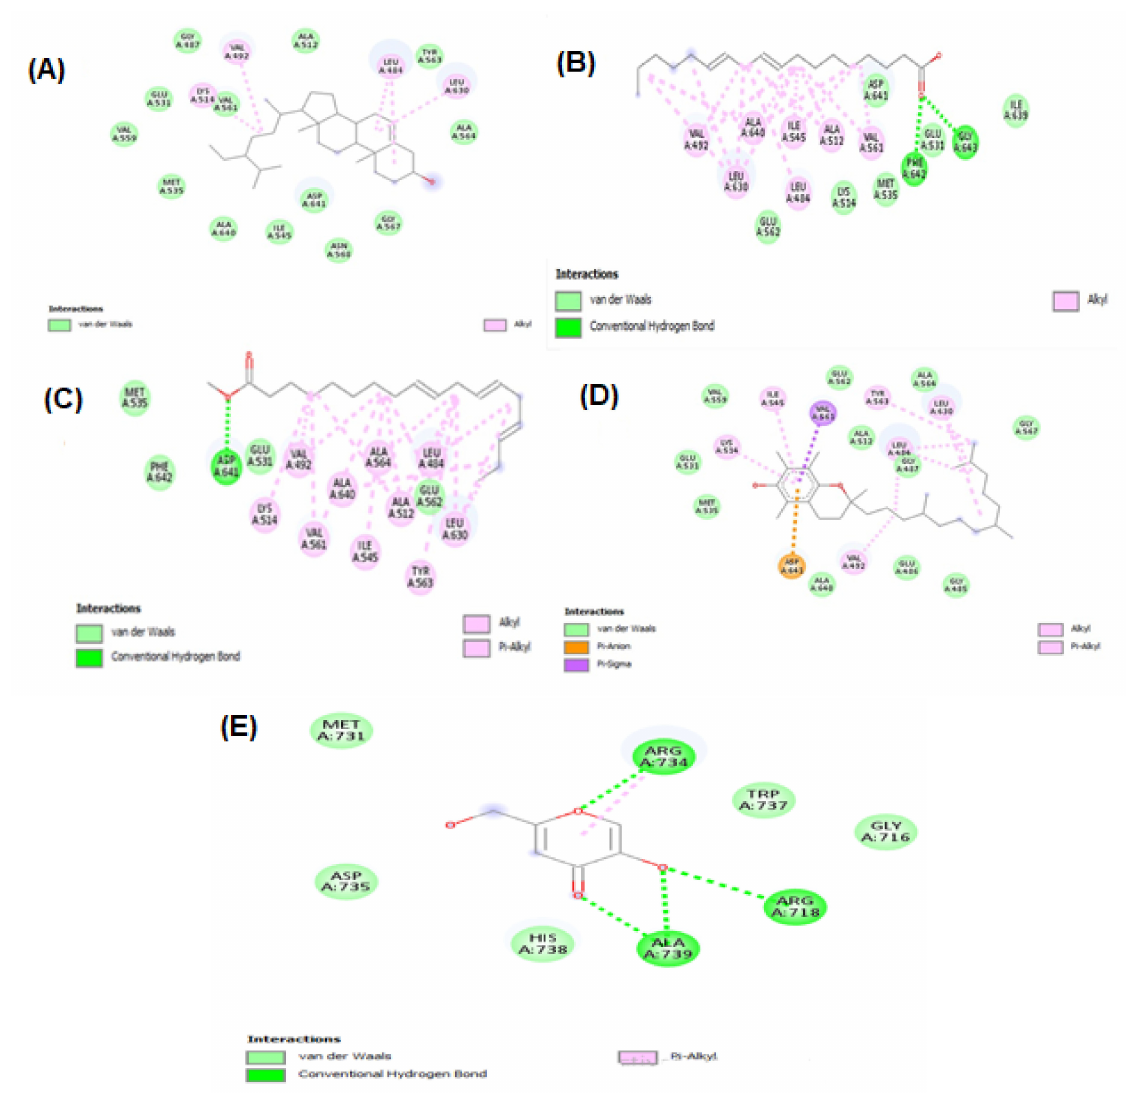
Figure 7. Interaction of tyrosinase and ligands. ( A ) Beta-sitosterol, ( B ) 9,12-octadecadienoic acid, ( C ) octadecatrienoic acid, methyl ester, ( D ) vitamin C, and ( E ) kojic